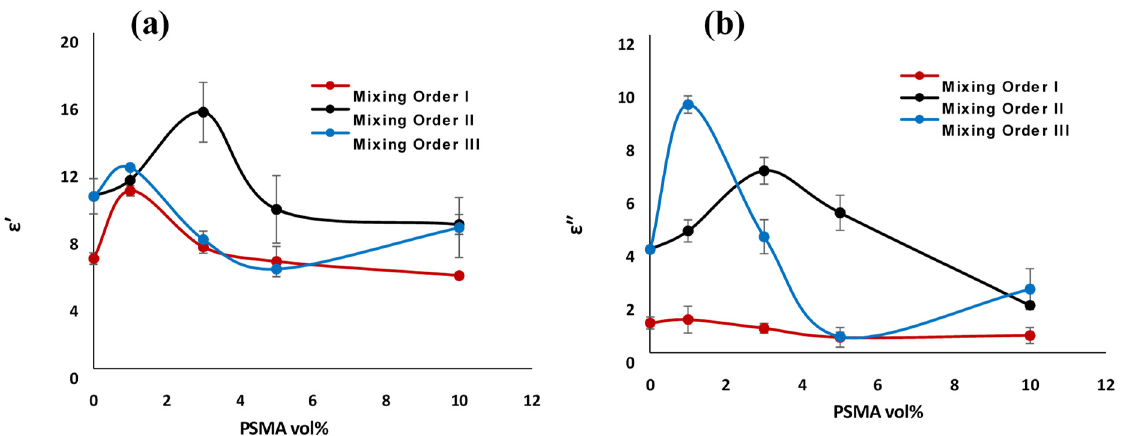
Figure 12. ( a ) Real permittivity and ( b ) imaginary permittivity of PS/aPA6/25:75 nanocomposites with 1.5 vol% CNT loading versus PSMA concentration.